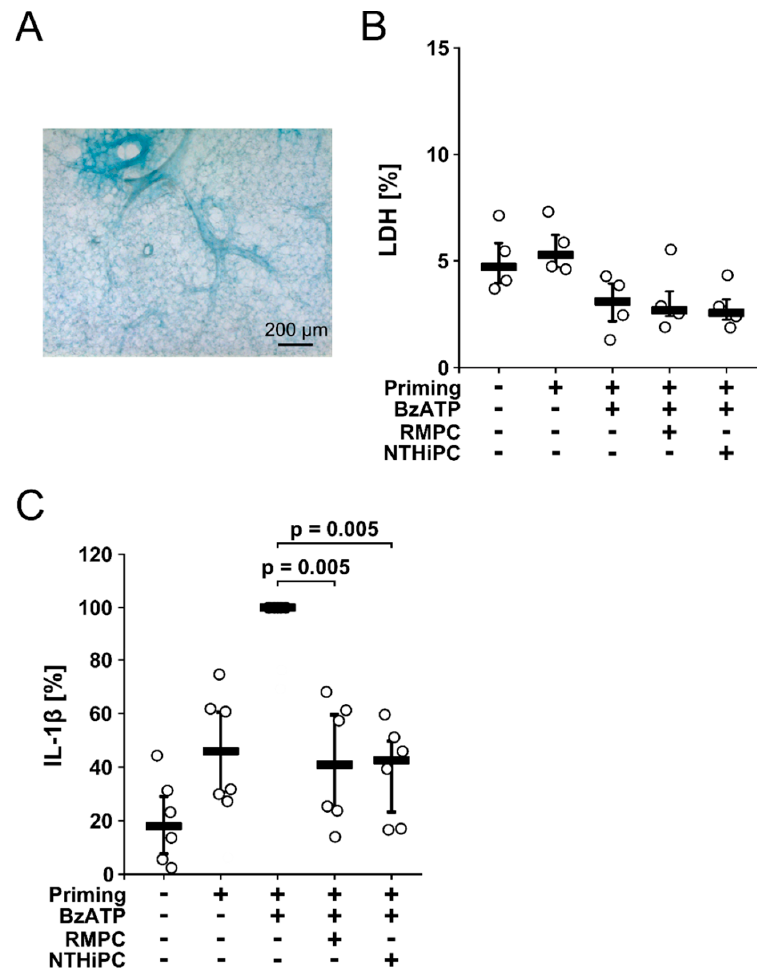
Figure 4. Phosphocholine-modified lipooligosaccharides (PC-LOS) isolated from H. influenzae strains inhibit the release of IL-1 β by wild-type mouse precision cut lung slices (PCLS, n = 6). ( A ) A fixed PCLS, lightly stained with Richardson’s stain depicts normal pulmonary morphology; ( B , C ) PCLS were primed with LPS (100 ng/mL), IFN- γ (20 ng/mL) and TNF- α (10 ng/mL) for 24 h followed by application of BzATP (150 µM) in the presence or absence of PC-LOS isolated from the H. influenzae strains RM118 (RMPC; 1 µg/ml) and NTHi 1233 (NTHiPC; 1 µg/mL); ( B ) Lactate dehydrogenase (LDH) was measured in the cell culture supernatant 30 min later and expressed as % of the total LDH content of the individual PCLS ( n = 4). Due to a technical problem, LDH release was not measured in two out of six experiments; ( C ) IL-1 β was measured in cell culture supernatant at the same time point as the LDH ( n = 6). The IL-1 β concentration in experiments where primed PCLS were stimulated with BzATP was set to 100% and all other values were calculated accordingly. ( B , C ) Data are presented as individual data points, bars represent median, whiskers encompass the 25th to 75th percentile. Experimental groups were compared by the Wilcoxon signed-rank test. Thereafter, PCLS were primed with LPS (100 ng/mL), interferon- γ (IFN- γ ; 20 ng/mL) and TNF- α (10 ng/mL) for 24 h and BzATP (100 µM) was added to the tissue culture supernatant for 30 min in